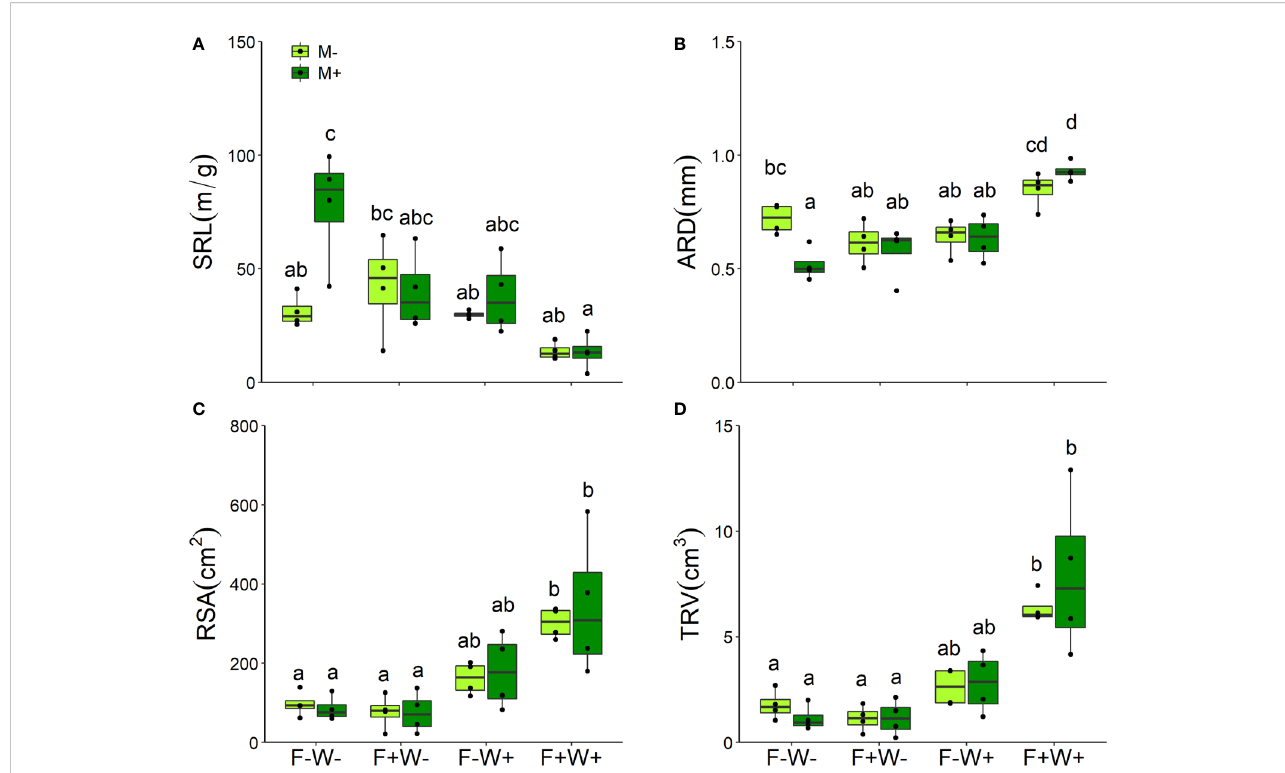
FIGURE 4 Speci fi c root length (SRL, A ), averaged root diameter (ARD, B ), root surface area (RSA, C ), and total root volume (TRV, D ) of Artemisia ordosica plants that were inoculated with the AM fungal species Funneliformis mosseae (M+) or not (M-) and grown under four different combinations of fertilization (F-: no fertilization; F+: fertilization) and water addition (W-: low soil water; W+: high soil water) treatments. Light symbols: plants received no AMF; dark symbols: plants inoculated with AMF. The boxplot shows the 25% and 75% quartiles, the median, whiskers (1.5 times the interquartile range) and the outliers of the samples, and the points in the plot area represent different replicates of the corresponding treatment. Boxplots sharing one or more identical letters are not signi fi cantly different based on Tukey ’ s post hoc test. Statistics are shown in Table 2.